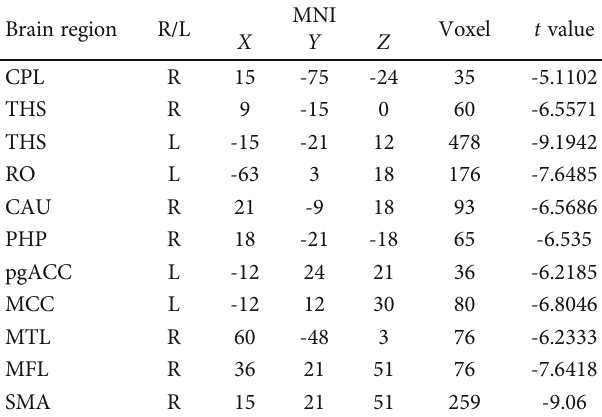
Table 9: Locations of the regions showing signi fi cantly altered EC with the rACC in placebo response compared with nocebo response in EG ( p < 0 : 05 , FDR < 0 : 05